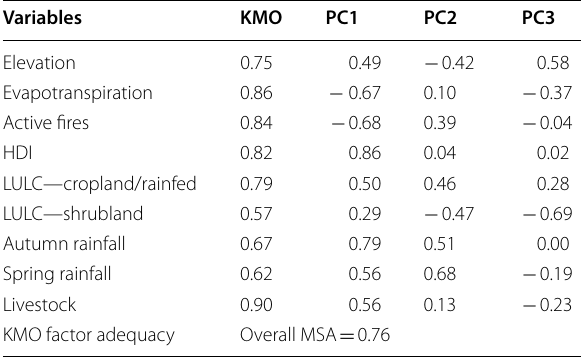
Table 2 Correlation analysis (CA) of the variables analyzed for PC1, PC2, and